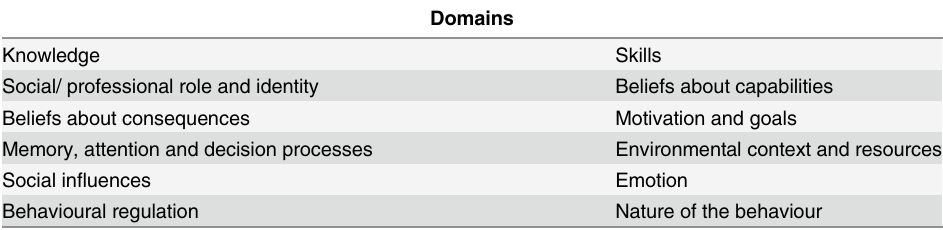
Table 1. Domains with the Theoretical Domains Framework